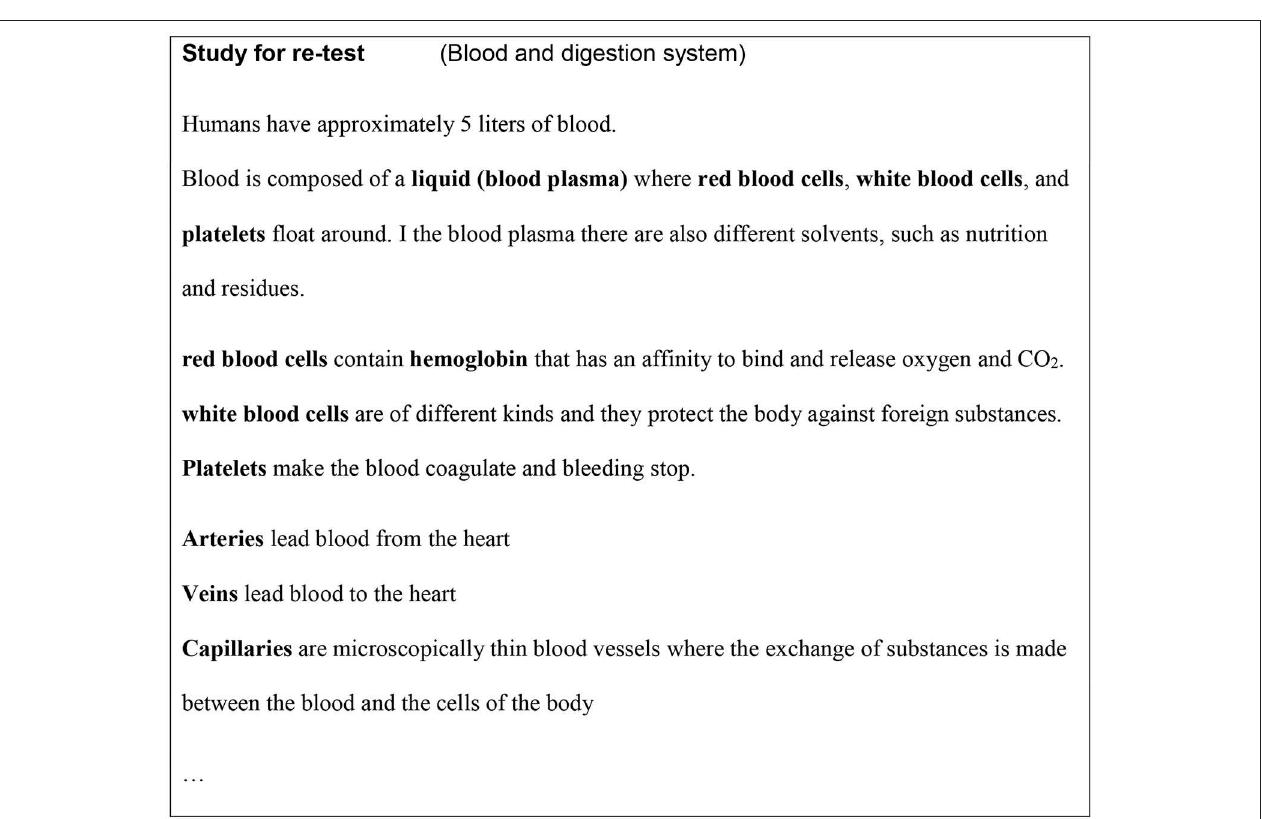
FIGURE 1 | Excerpt from study material about the human body for low-performing students. The study material, which covers only one page, includes isolated facts about blood and the human digestion system (the latter not shown in the figure), where biological concepts are highlighted with bold fonts. This particular excerpt is from School C, but several other schools in the sample had very similar study